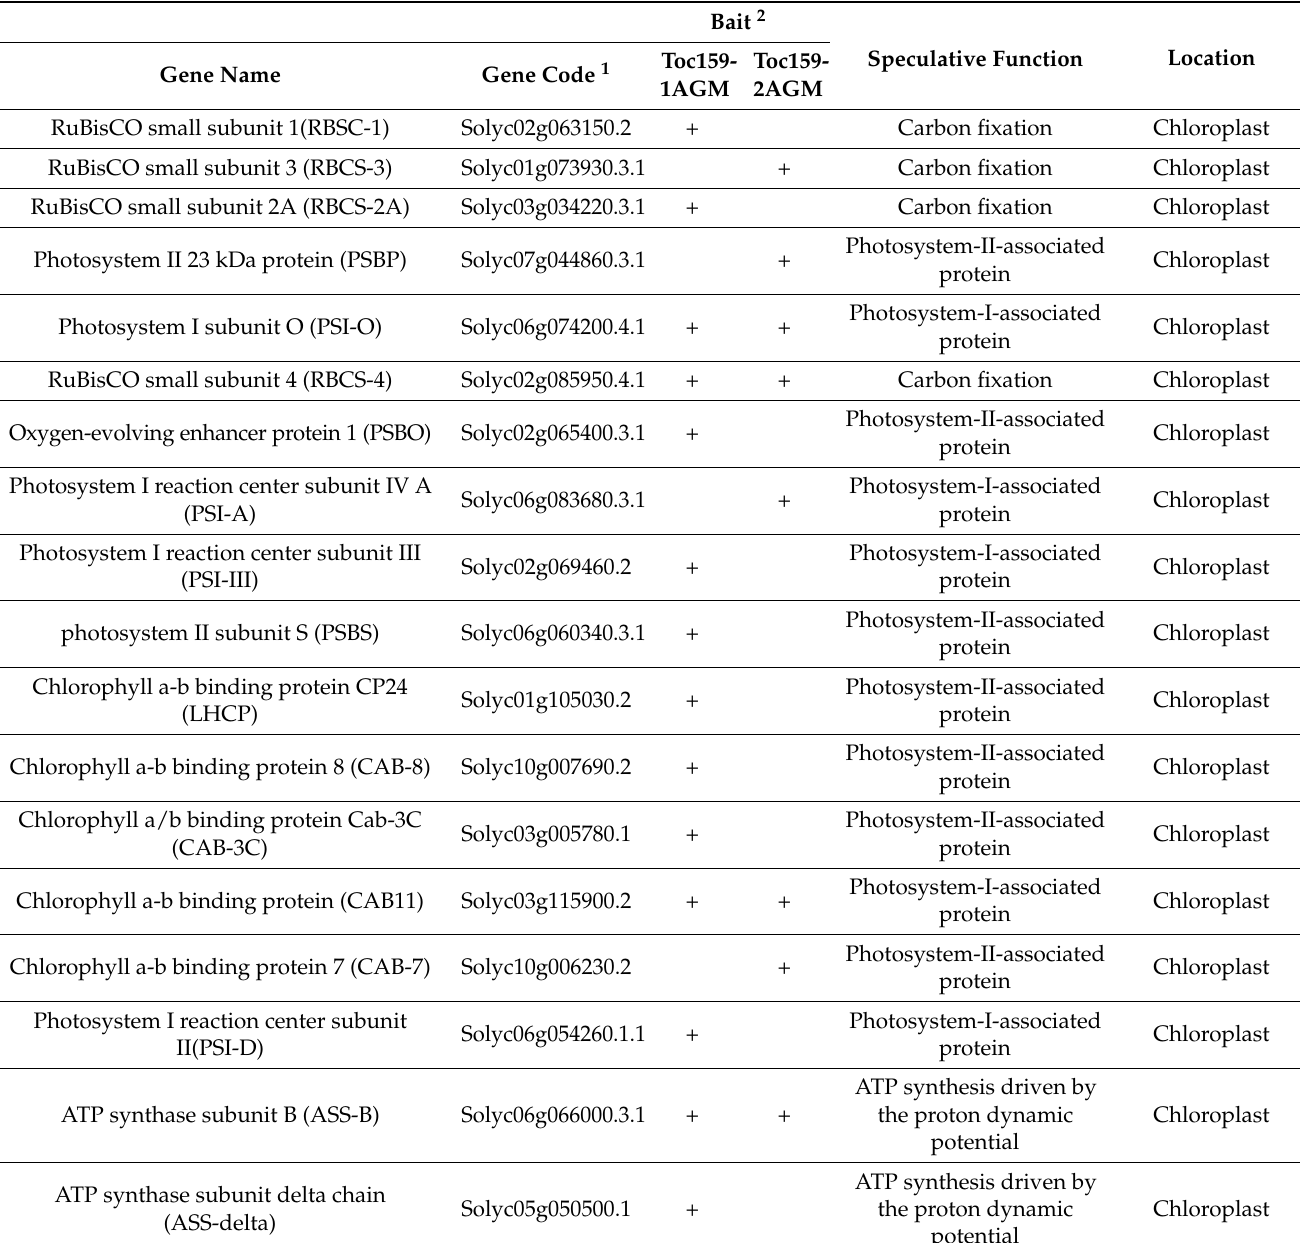
Table 2. Photosynthesis-related proteins identified to interact with slToc159-1 and slToc159-2 in a split-ubiquitin yeast two-hybrid